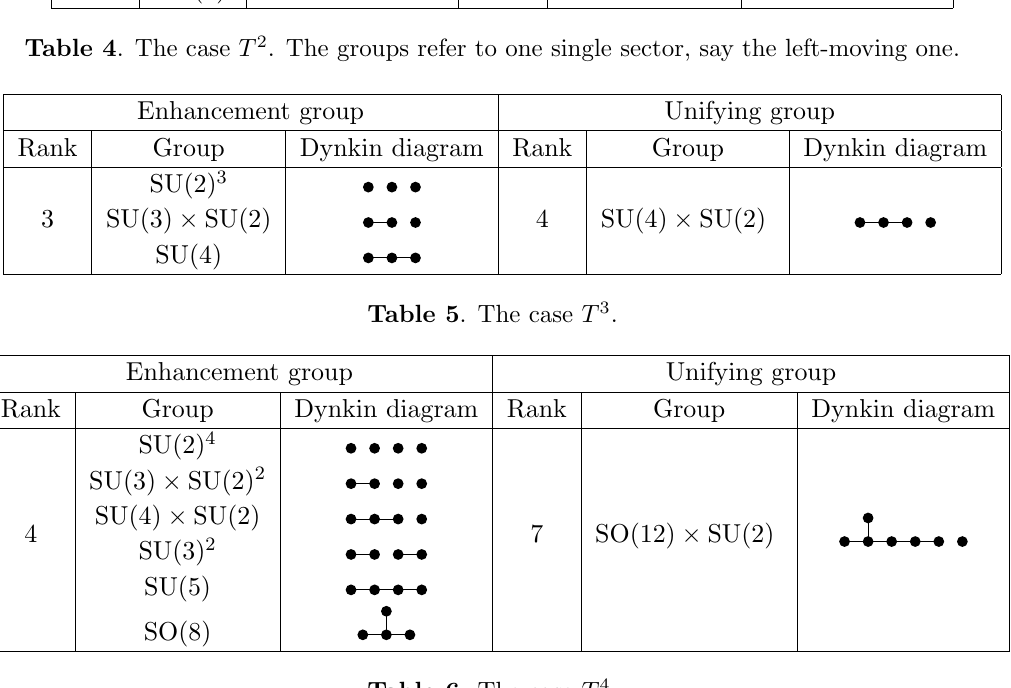
Table 6 . The case T 4